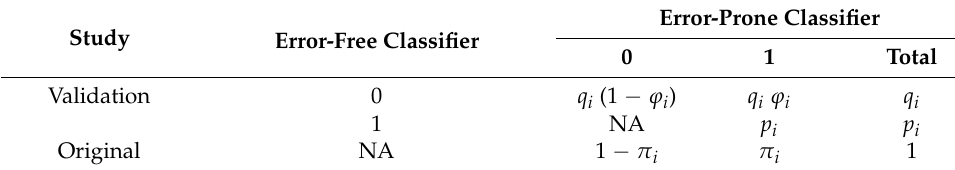
Table 2. Cell probabilities for group i